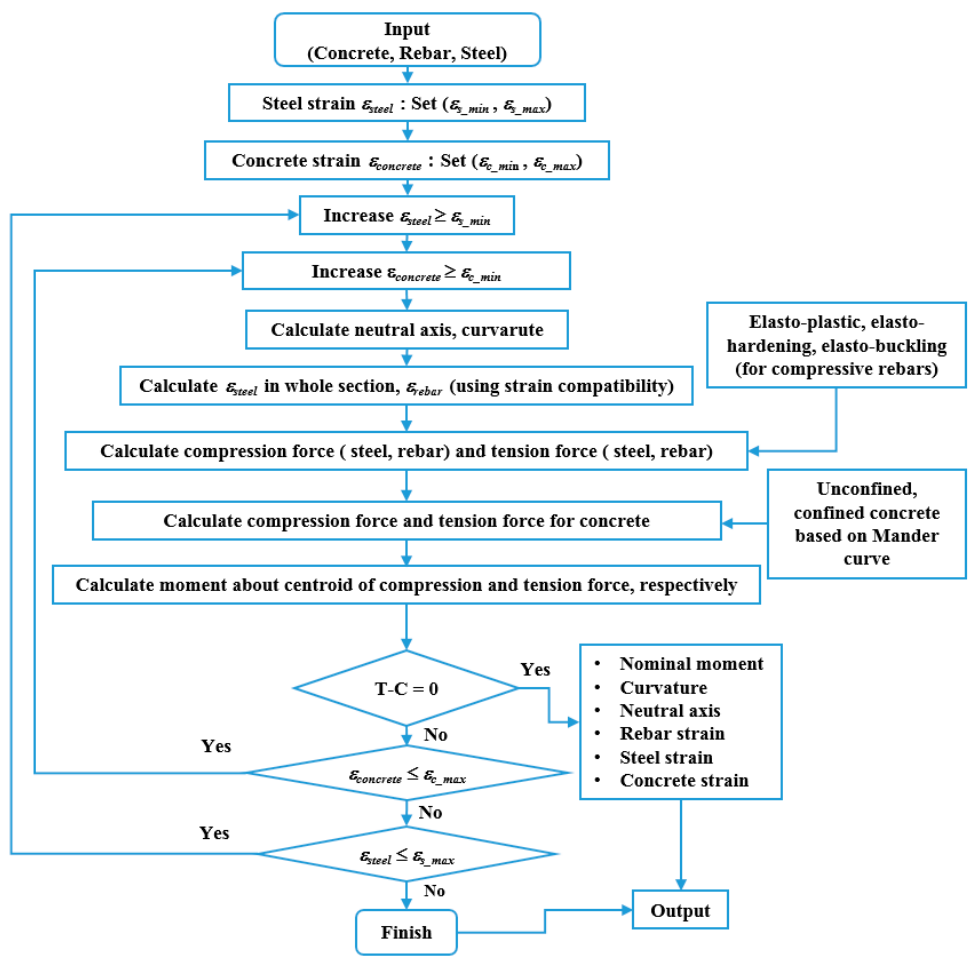
Figure 4. Computing algorithm based on strain compatibility.